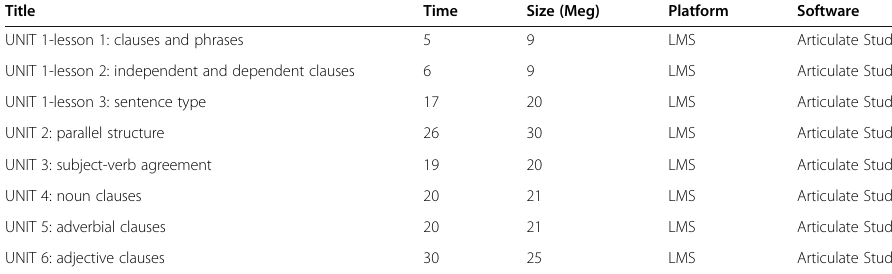
Table 5 Information regarding the software used for making